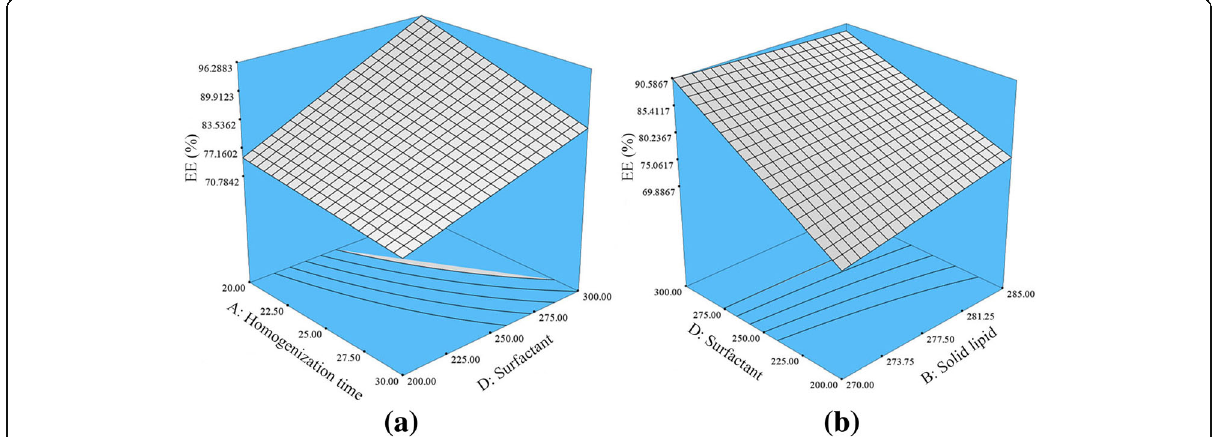
Fig. 5 Response surface plot depicting the significant ( p < 0.05) effect of homogenization time, liquid lipid concentration, surfactant concentration, and interactions between a AD and b BD on EE of verapamil in HVD-NLCs. A homogenization time, B solid lipid, D